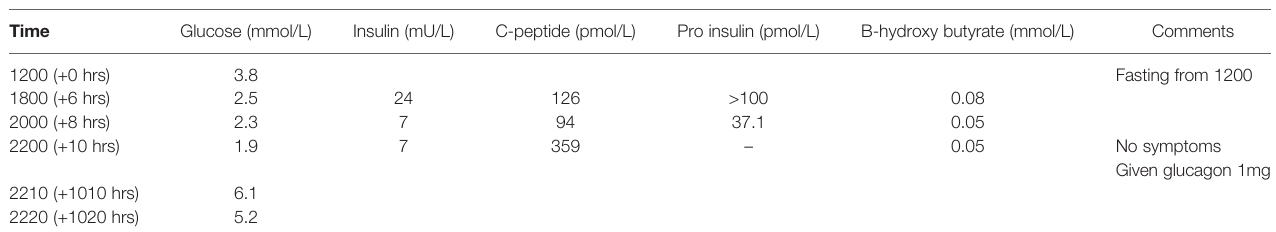
TABLE 2 | Prolonged fasting